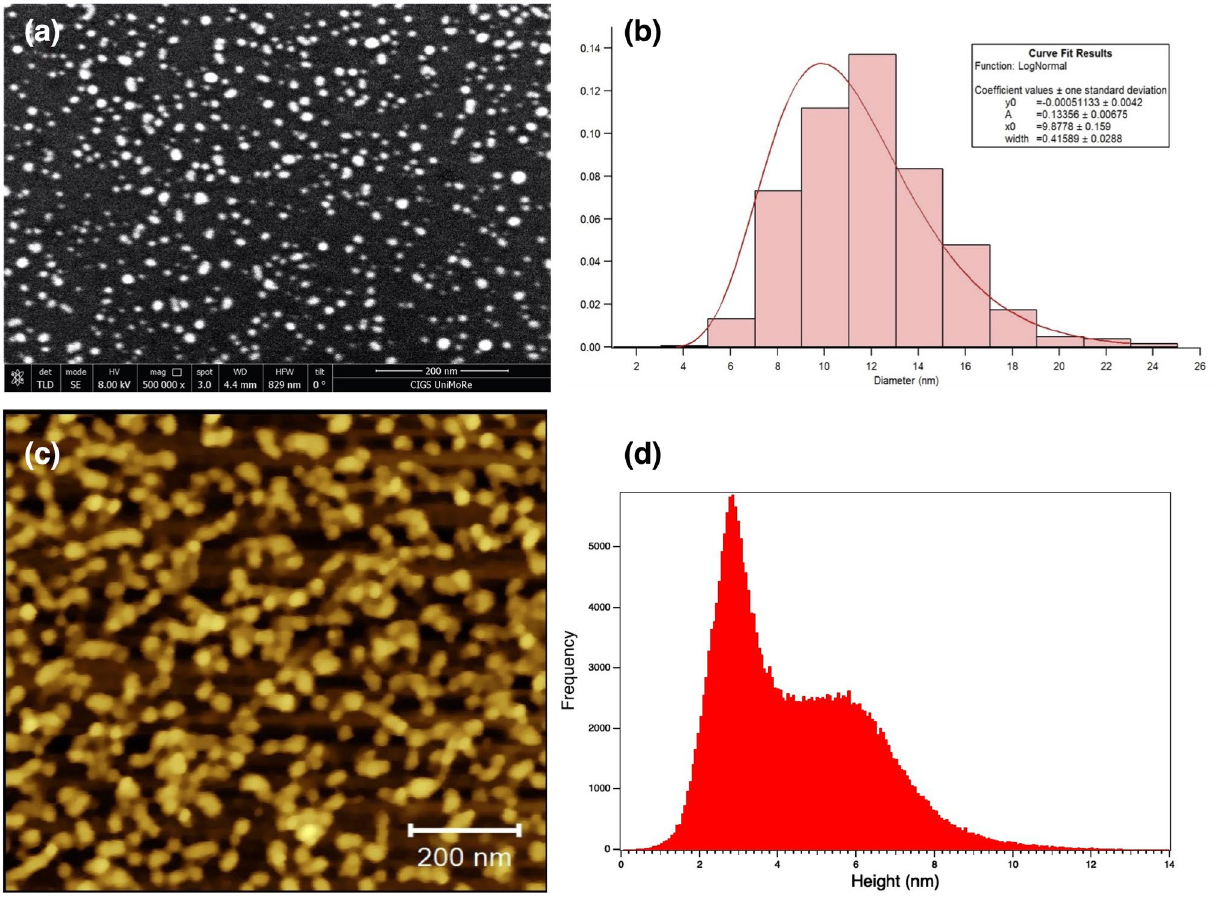
Fig. 2 a SEM image of Ag NP deposited on Si-SiO . Fractional coverage C = 14%. b histogram showing the lateral size distribution as x obtained by grain analysis of ( a ). c AFM image from the same sample as ( a ). d Height distribution obtained by the line profile analysis of ( c